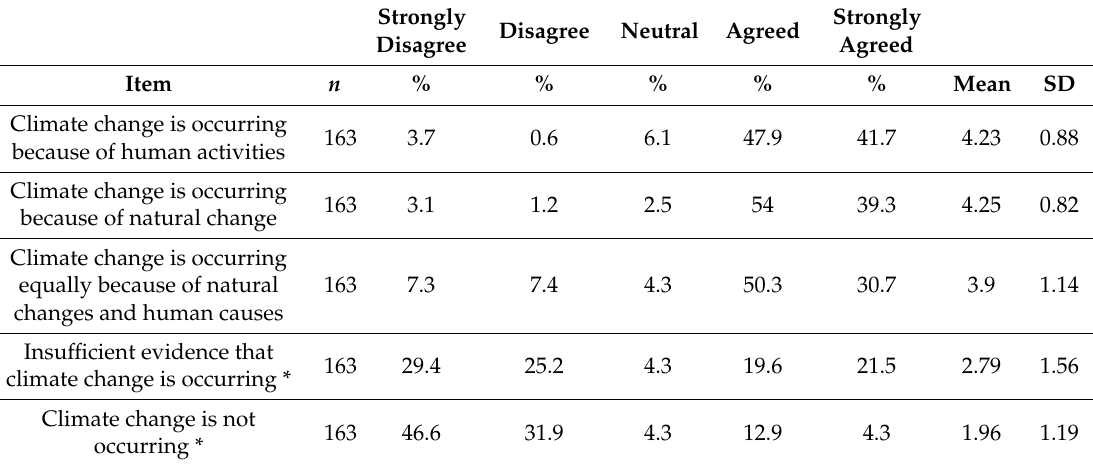
Table 2. Distribution of farmers’ beliefs regarding climate change.